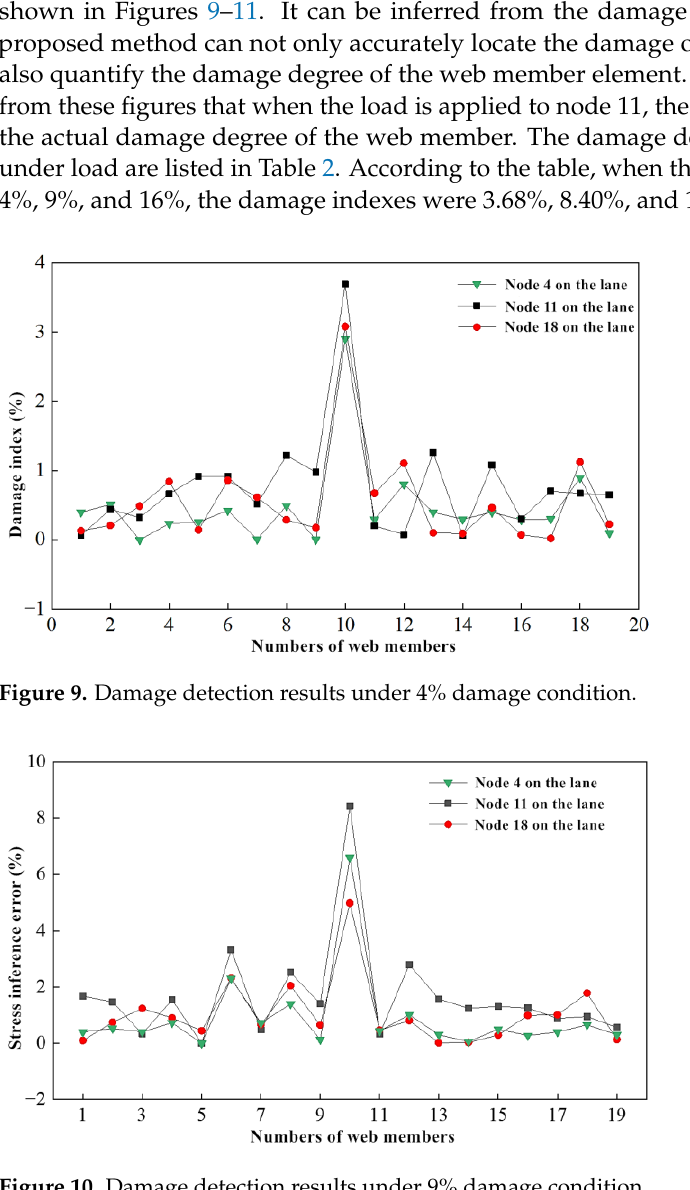
Figure 10. Damage detection results under 9% damage